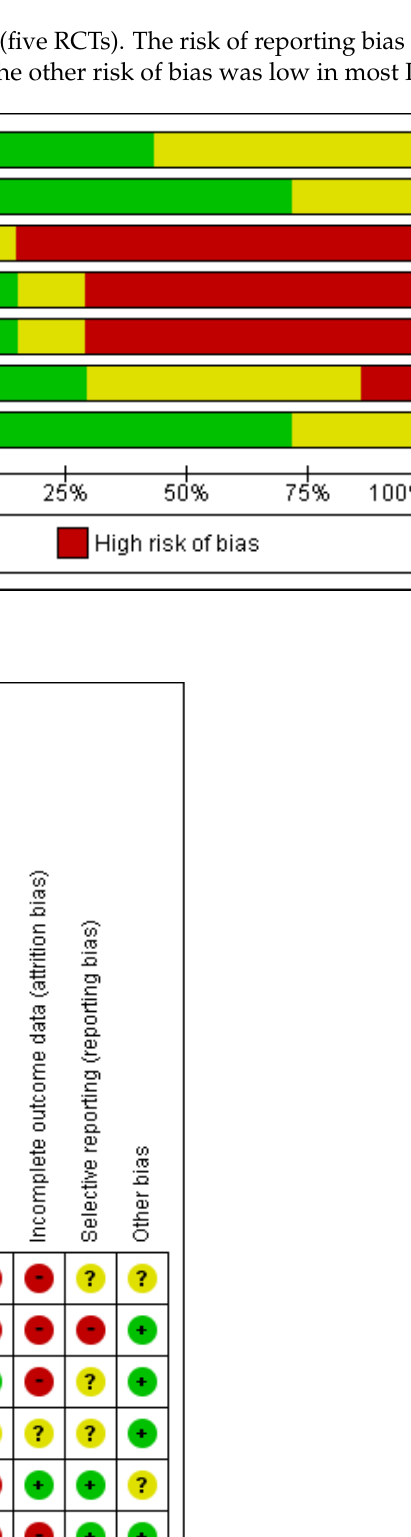
Figure 3. Risk of bias summary [19 – 25]. Red color with a － symbol means a high risk of bias, yel- low color with a ? symbol means an unclear risk of bias, and green color with a + symbol means a low risk of bias.